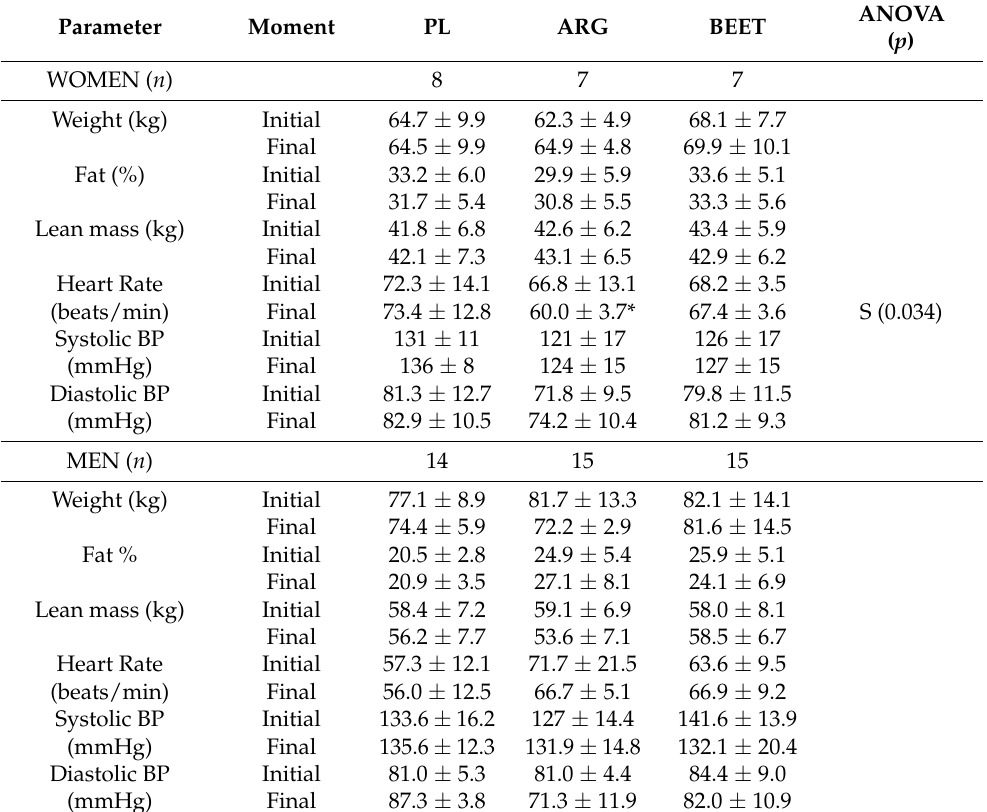
Table 2. Effect of L -arginine or beetroot extract supplementation on anthropometric and cardiovascu- lar parameters of men and women trained for six